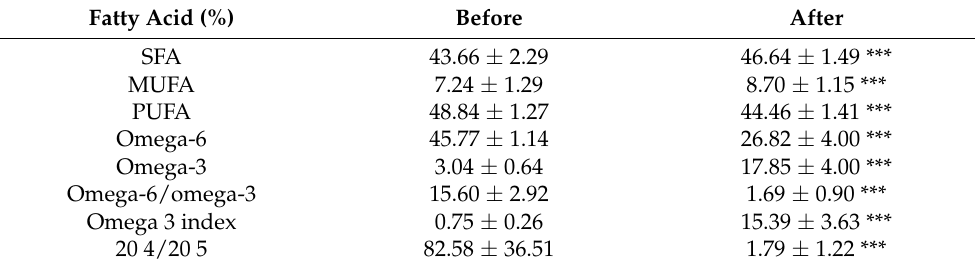
Table 3. Cont. Fatty Acid (%) Before